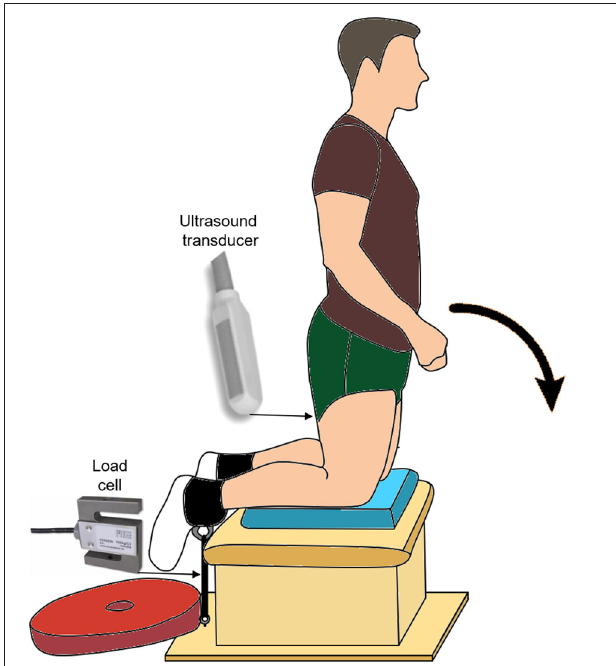
FIGURE 1 | Experimental setup showing the beginning posture for the Nordic hamstring exercise (NHE). The participants’ end posture was slightly below horizontal, as their upper body was supported on a box (not shown here) that was half the height of the box under their shanks. The approximate location and type of ultrasound transducer, as well as the approximate location and type of load cell, are also